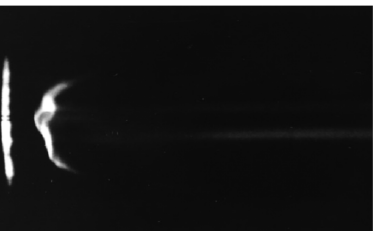
Figure 20. Streak photographs of flyers taken by scanning camera [81].